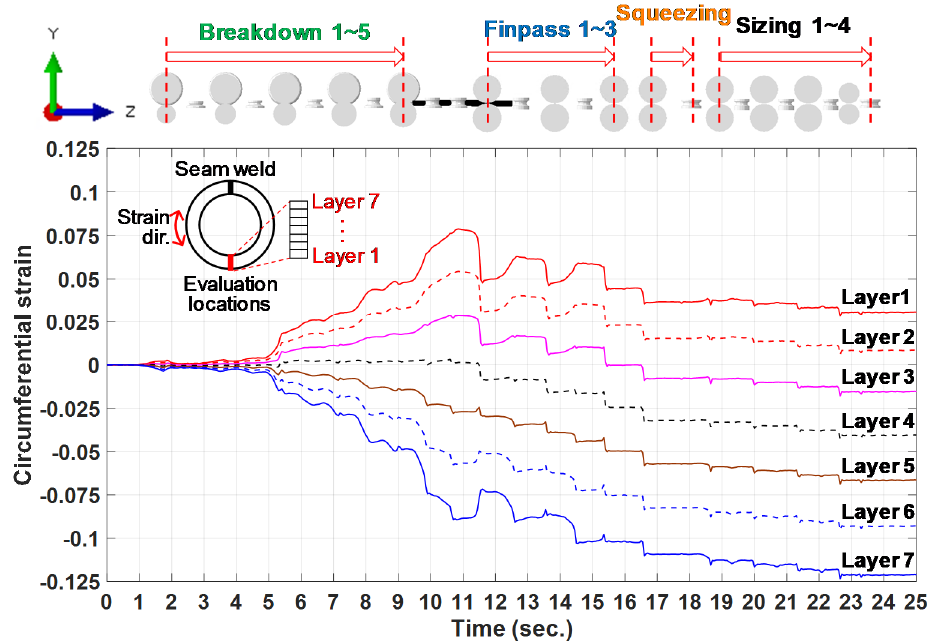
Figure 8. Strain history of each layer during the manufacture process.